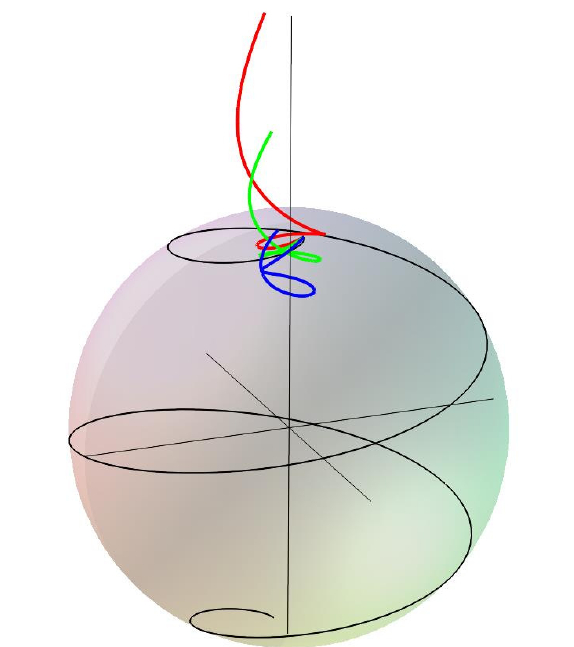
Figure 1. Three rectifying curves constructed from a spherical curve: a spherical helix and three evolutes of